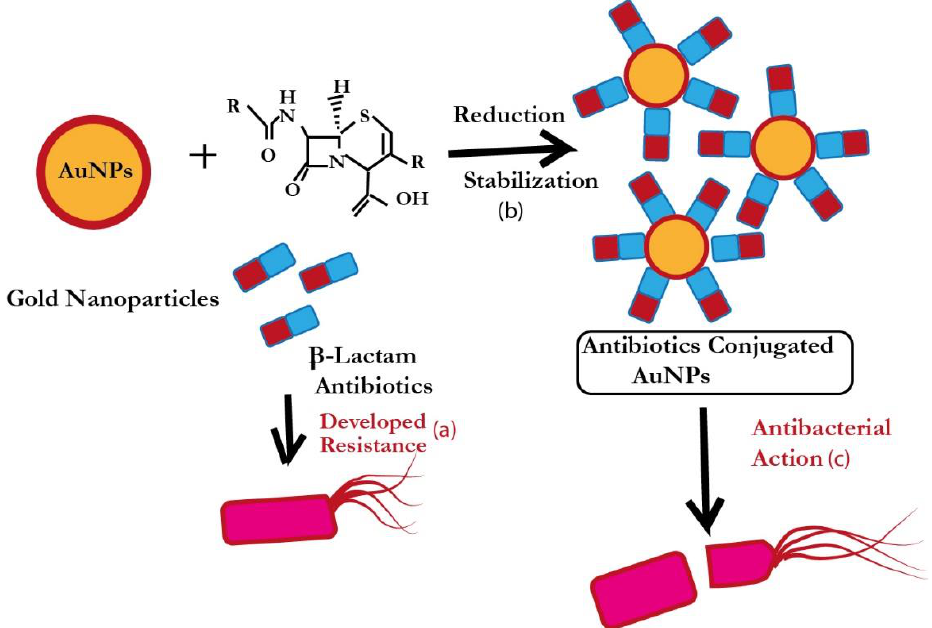
Figure 3. Schematic description of revival of β -lactam antibiotics by AuNPs. ( a ) Bacterial pathogens develop resistance towards β -lactam antibiotics; ( b ) AuNPs were synthesized using the same inef- fective β -lactam antibiotic as reducing and stabilizing agent; ( c ) β -lactam antibiotic after loading to AuNPs become potent against the same β -lactam resistant bacterial pathogen.